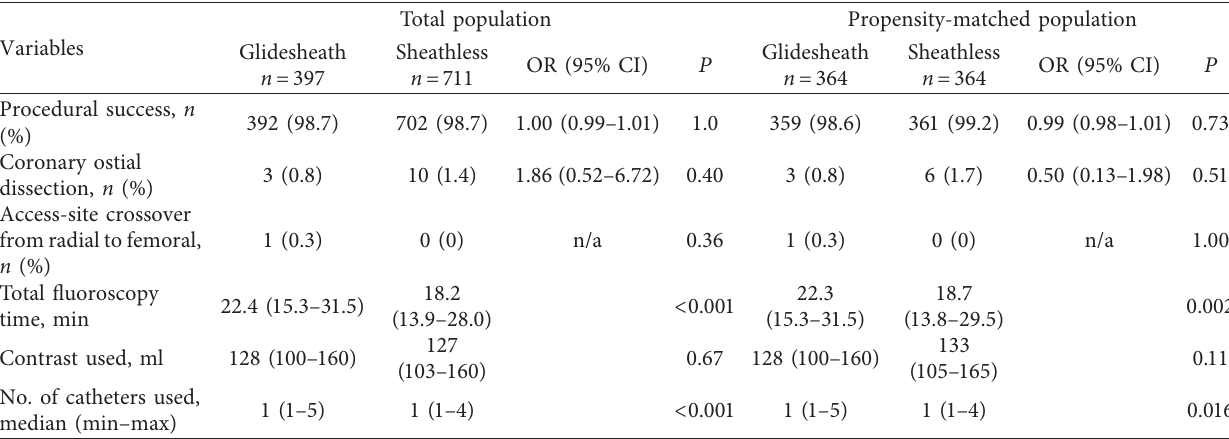
Table 3: Procedural outcomes.